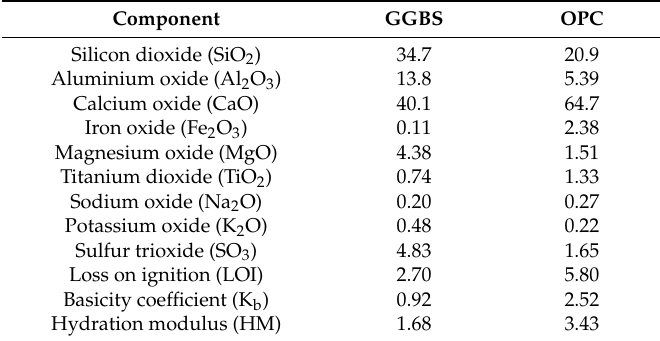
Table 1. Chemical composition (% by mass) of GGBS and OPC.